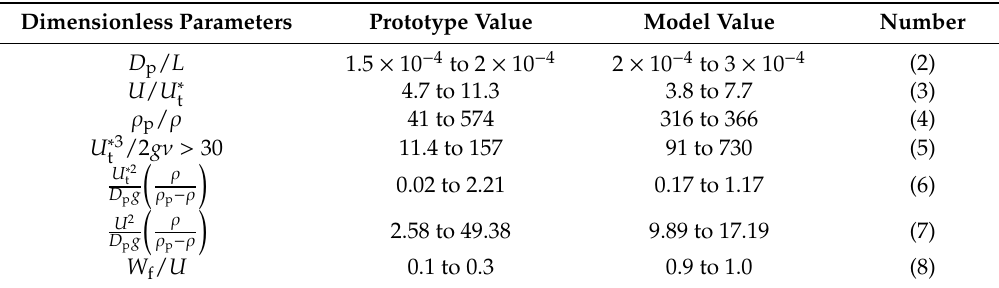
Table 3. Similitude